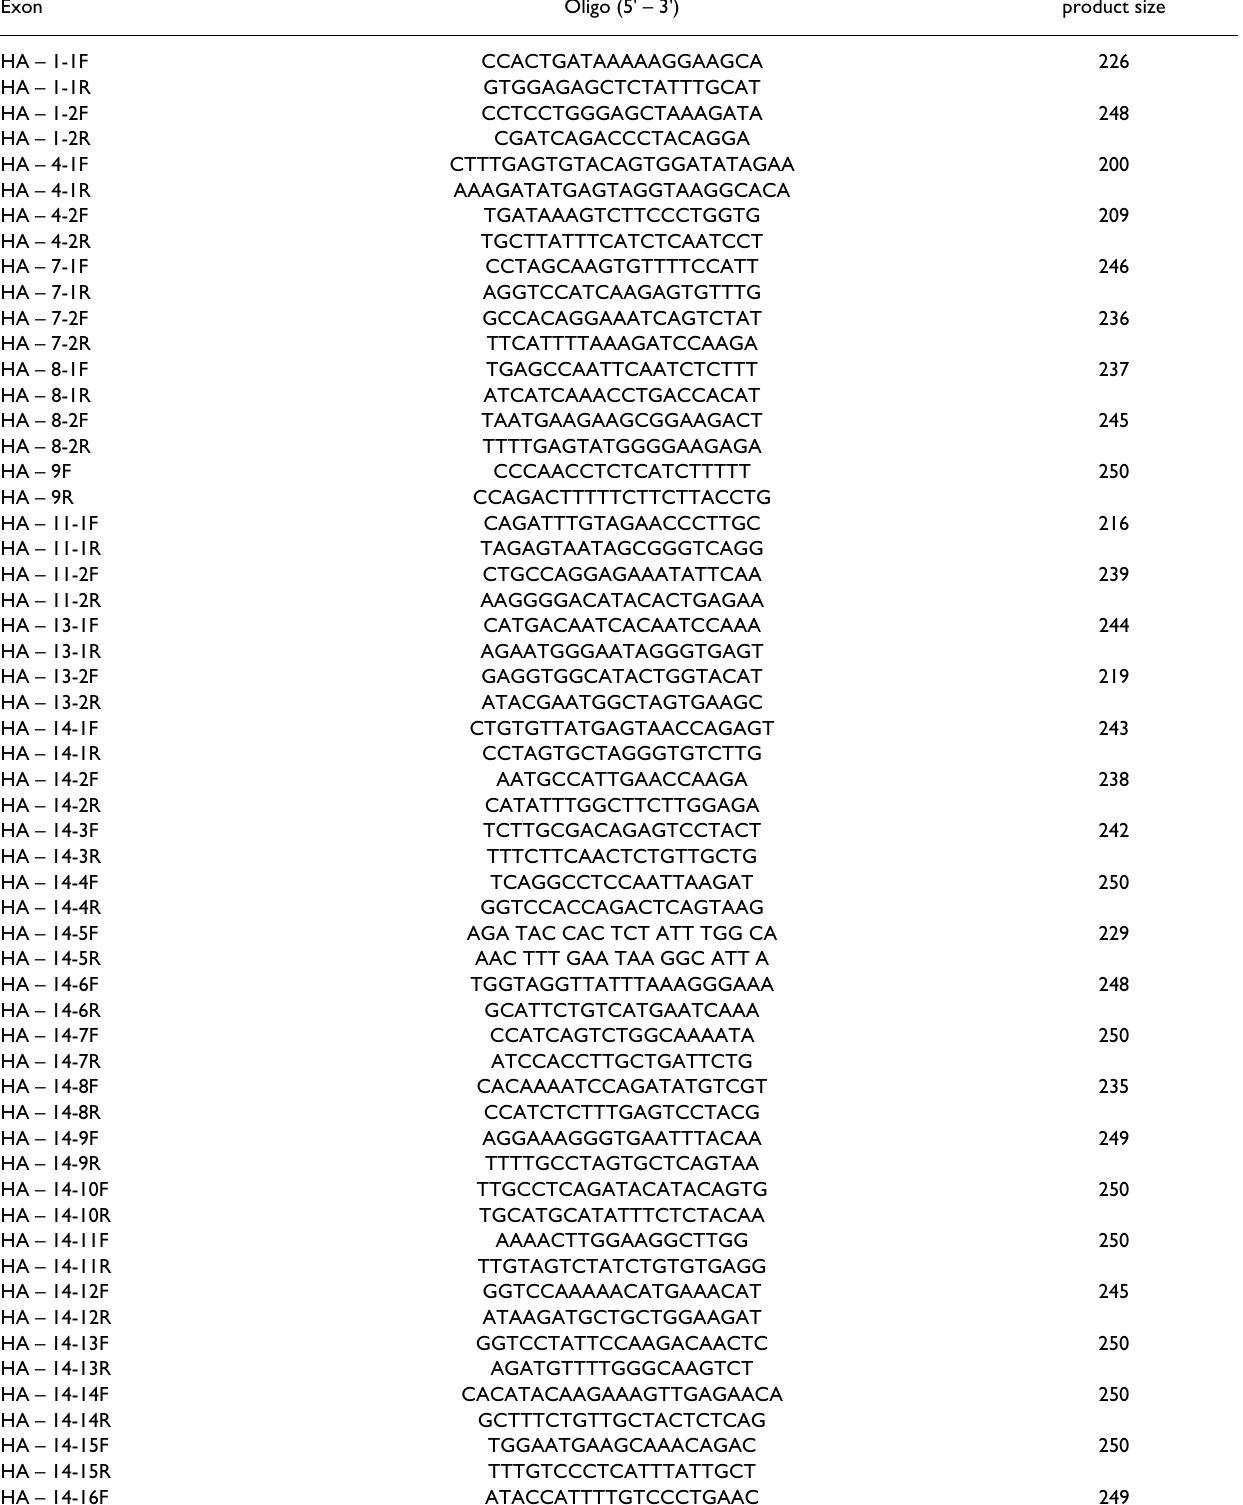
Table 2: Redesigned primer pairs for